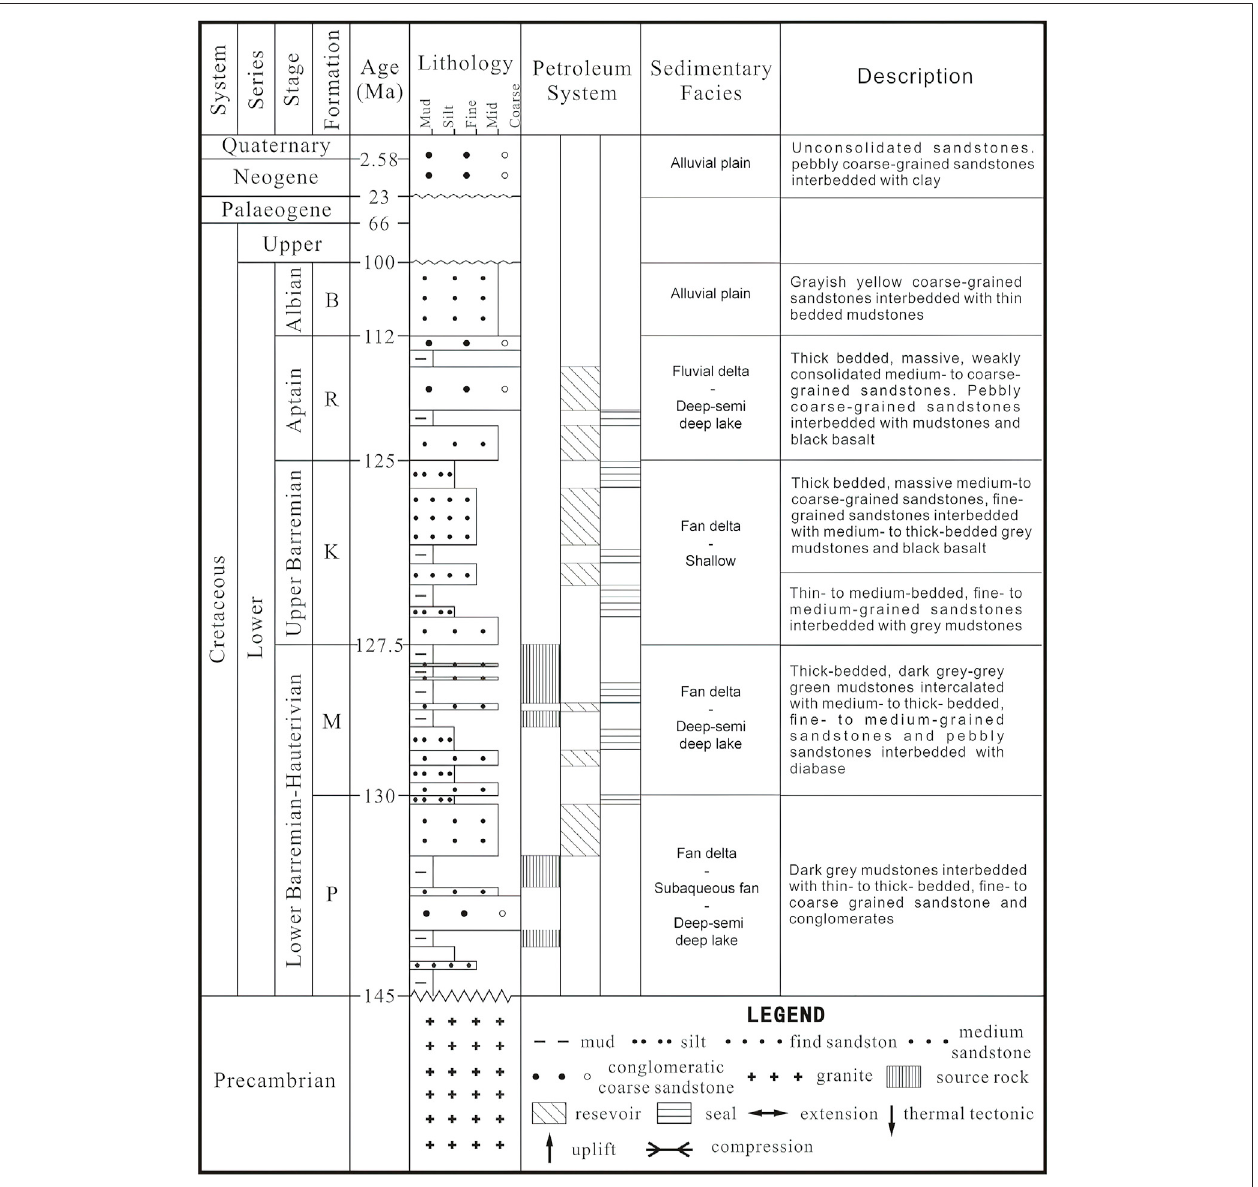
FIGURE 2 | Comprehensive stratigraphic histogram of the Bongor Basin (Modi fi ed from Chen et al., 2018).